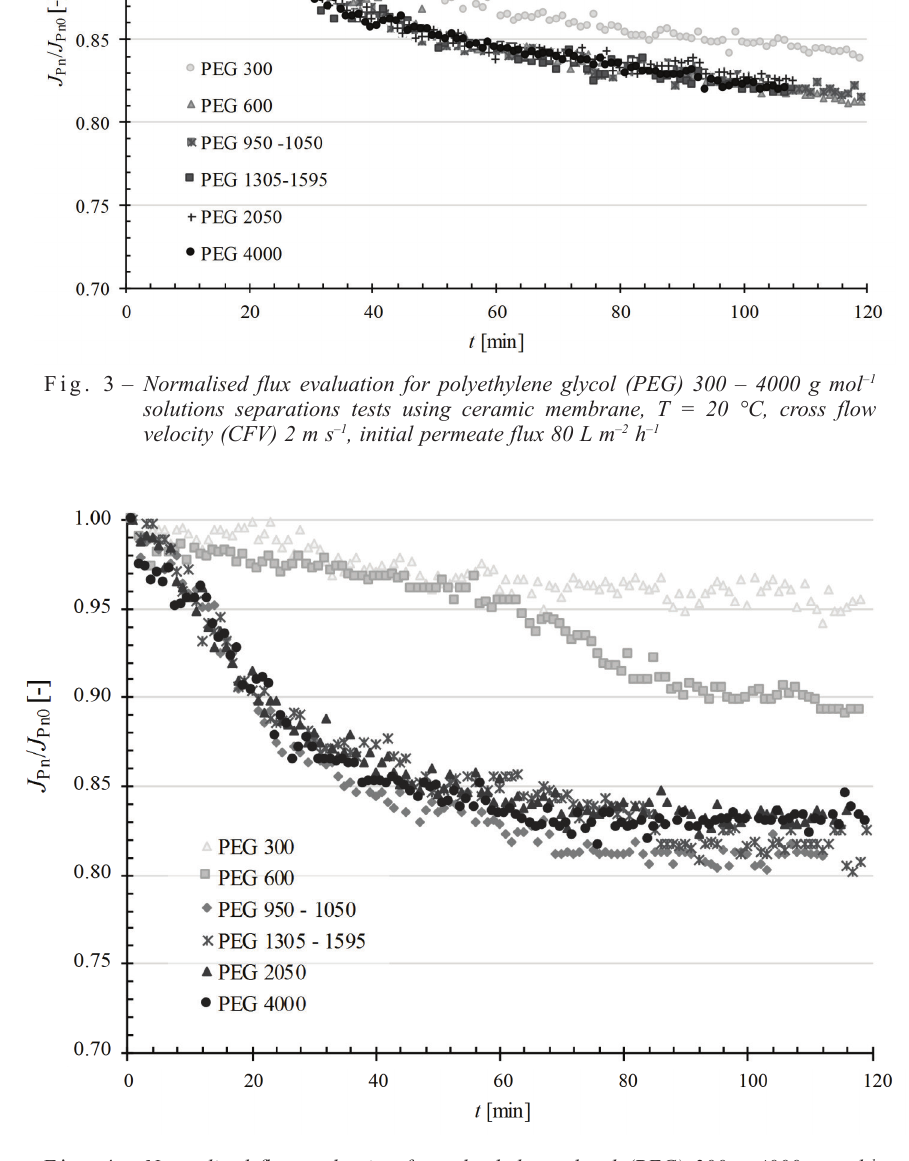
Fig. 4 – Normalised flux evaluation for polyethylene glycol (PEG) 300 – 4000 g mol –1 solutions separations test using polyethersulfone (PES) membrane, T = 20 °C, cross flow velocity (CFV) 0.32 m s –1 , initial permeate flux 80 L m –2 h